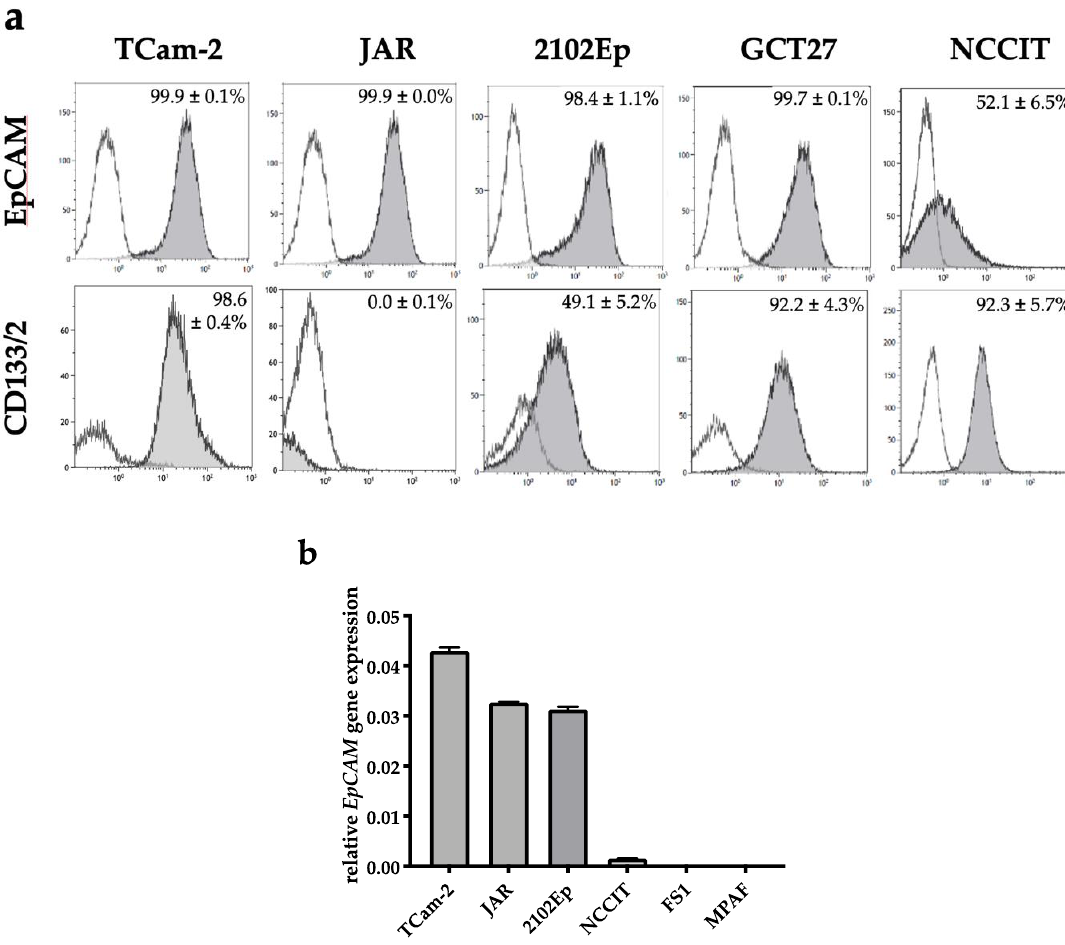
Figure 1. Expression of Epithelial Cell Adhesion Molecule (EpCAM) and CD133 mRNA and protein on the cell surface is detectable in germ cell tumours (GCT) lines of different histologies. ( a ) EpCAM and CD133 proteins (grey peak of the histogram) on the tumor cell surface of five GCT cell lines were assessed by flow cytometry in comparison to the isotype control (transparent peak). The fraction of antigen-positive cells (mean ± SD) of 4–5 independent experiments is shown in percent in the upper right of each histogram. ( b ) Quantitative real-time PCR analysis of EpCAM mRNA expression in four GCT cell lines as well as in sertoli (FS1) and fibroblast (MPAF) control cells. Relative EpCAM gene expression levels were normalized against GAPDH and presented as 2 − ∆ ct values. Samples were analyzed in triplicates.